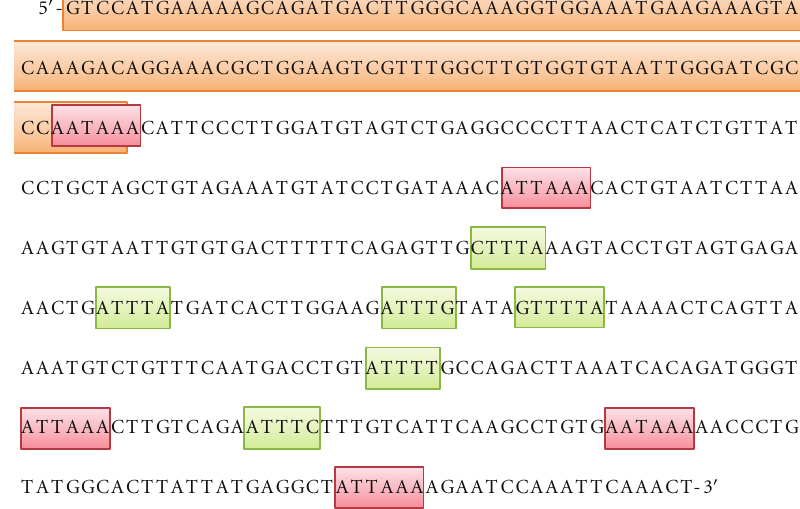
Figure 2: Nucleotide sequence of the fifth exon of SOD1 gene. The coding portion is highlighted in orange; the polyadenylation sites are in red, and the A/U-rich elements are in